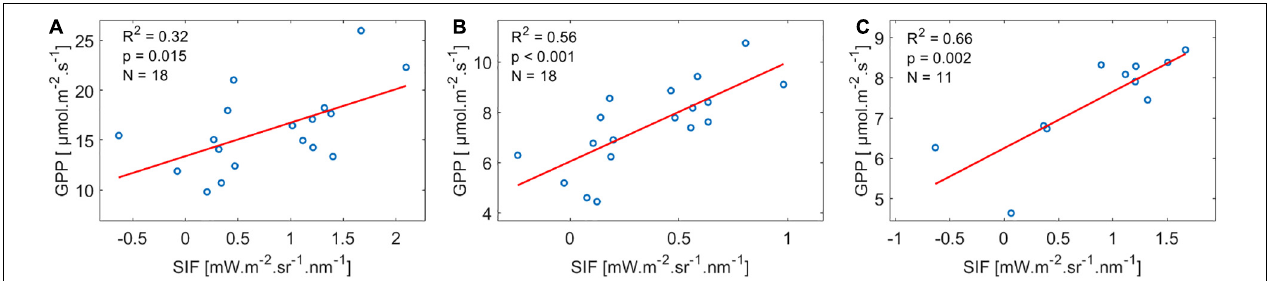
FIGURE 1 | Example for GPP:SIF relations, using data from SE-Nor, where GPP:SIF had the best goodness of fit at the site level. (A) Half-Hourly, (B) Daily, and (C) Weekly timescales. The red line represents the linear regression fit.